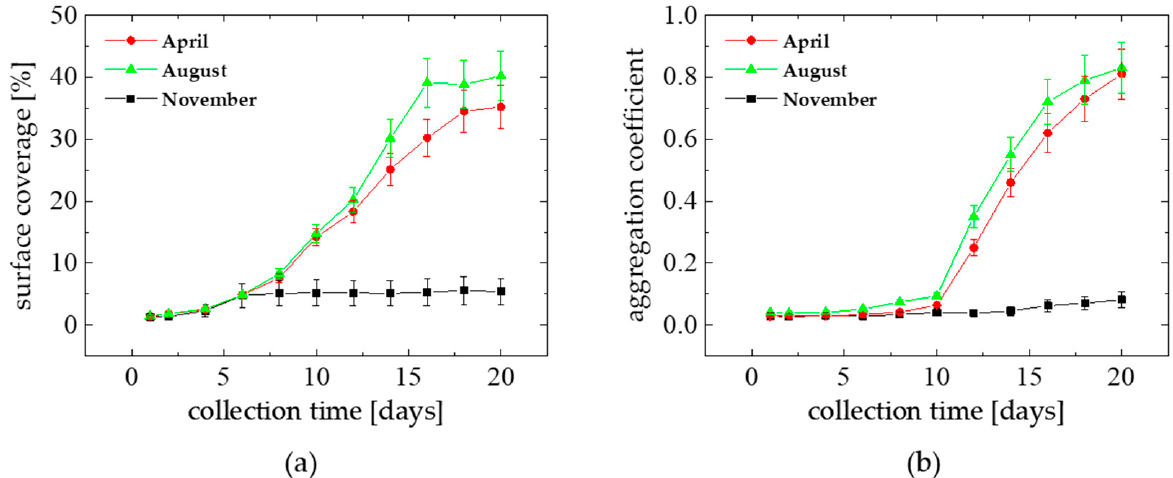
Figure 4. Biofilm surface coverage ( a ), and aggregation coefficient ( b ) versus sample collection time, for natural marine biofilm formation on a glass substratum in experiments performed in the Baltic Sea (Gulf of Gda´nsk, Poland) in different organic matter production seasons (April–November 2018). It is supposed that the biofilm deposition efficiency, in particular biovolume, covering fraction, should be related to the trophic state indexes of the water body. The principal biogenic elements and Chl. a concentration with Primary Production (PP) data, averaged over each month of 2018, registered in the biofilm sampling site, are collected in Table 1.